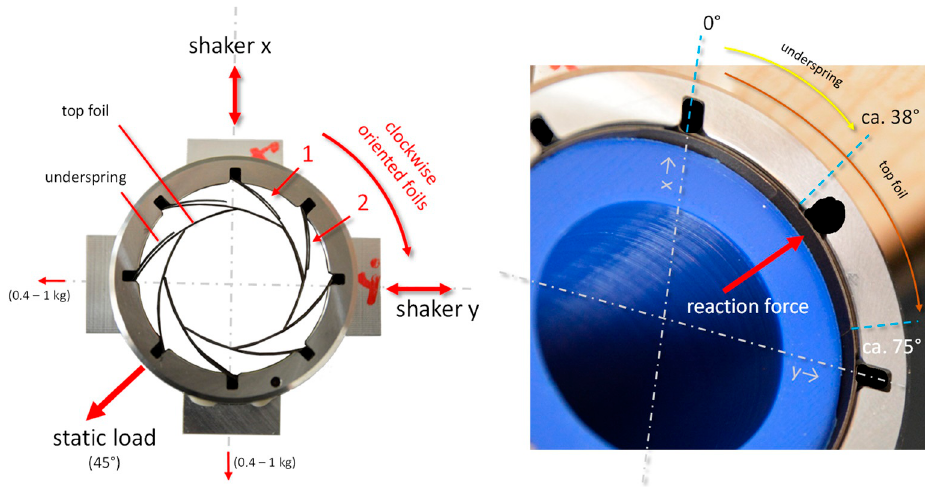
Figure 4. Top view of the tested leaf type bearing ( left ); leaf foil angular length and bearing ring motion ( right ).